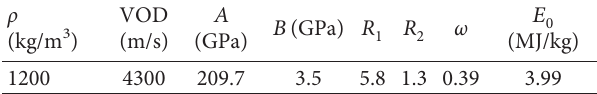
Table 2: Parameters of JWL